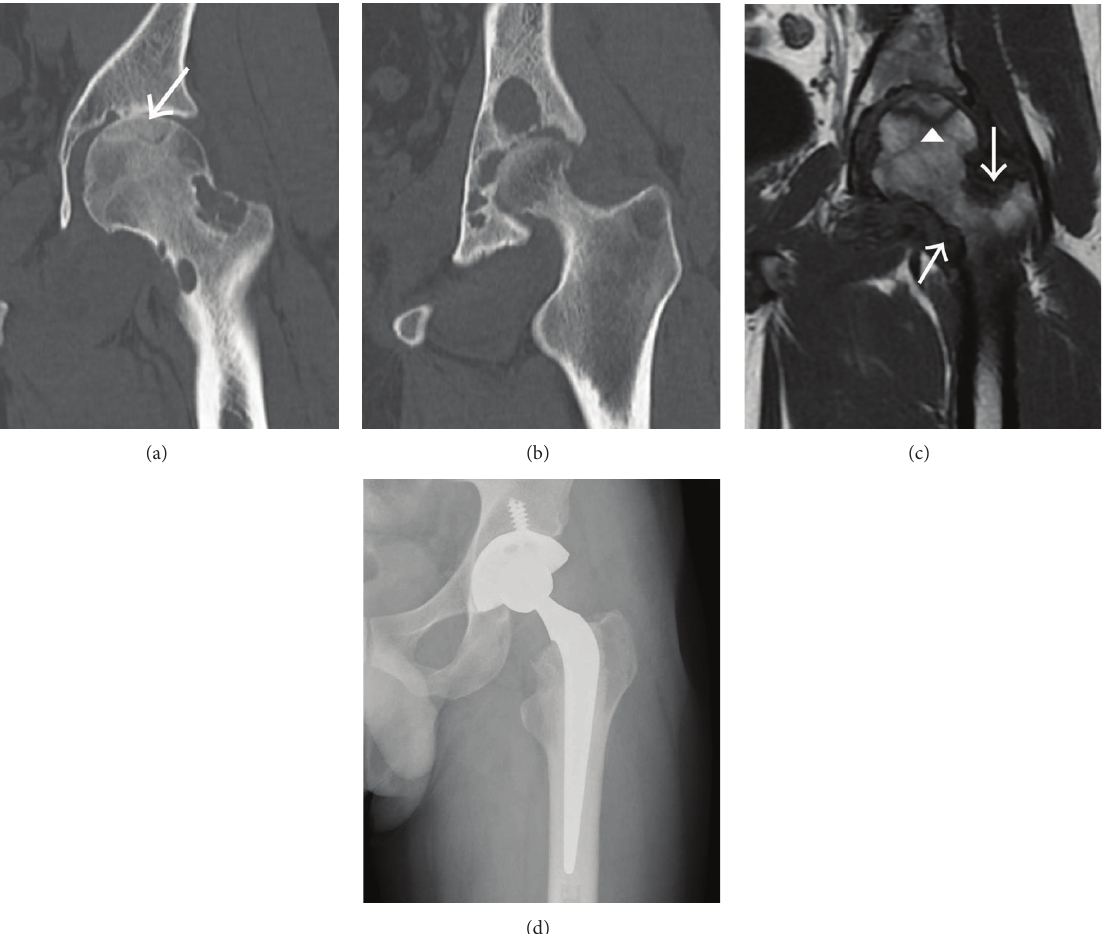
Figure 2: (a, b) Computed tomography image showing the femoral neck and acetabular bone erosions, and area of bone necrosis (arrow). (c) Magnetic resonance image showing a typical low-intensity band of osteonecrosis of the femoral head (arrowhead) and mass lesions (arrows) around the femoral neck on T1-weighted imaging. (d) The patient underwent total hip arthroplasty with complete synovectomy and tumor resection using an argon